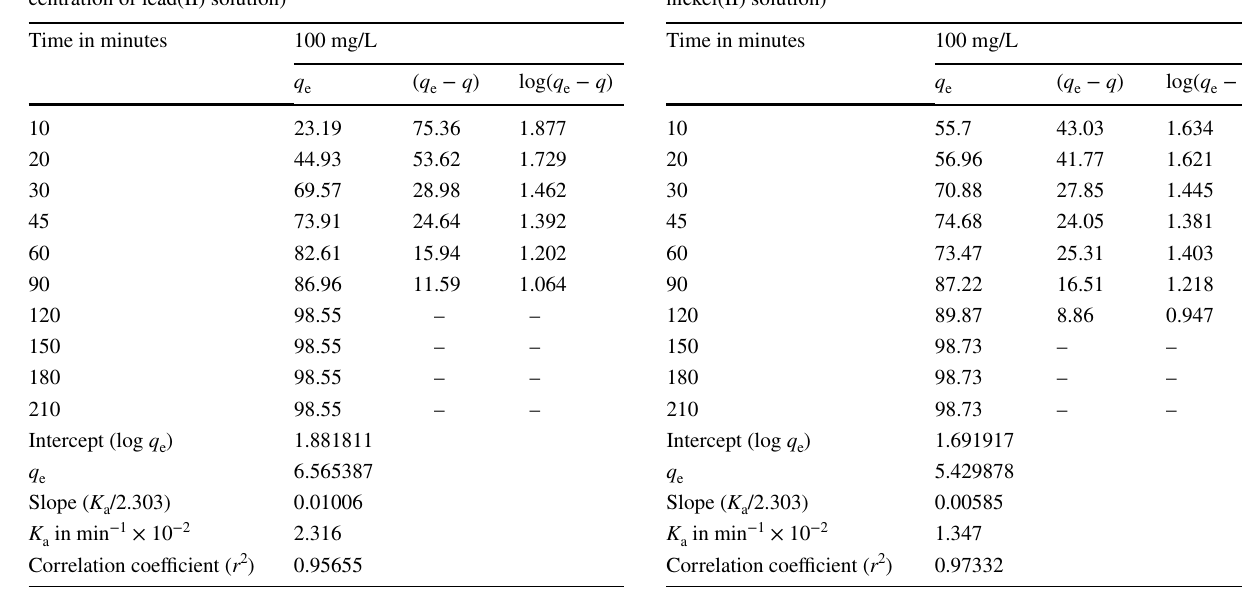
Table 4 Kinetic modelling for adsorption of nickel(II) metal